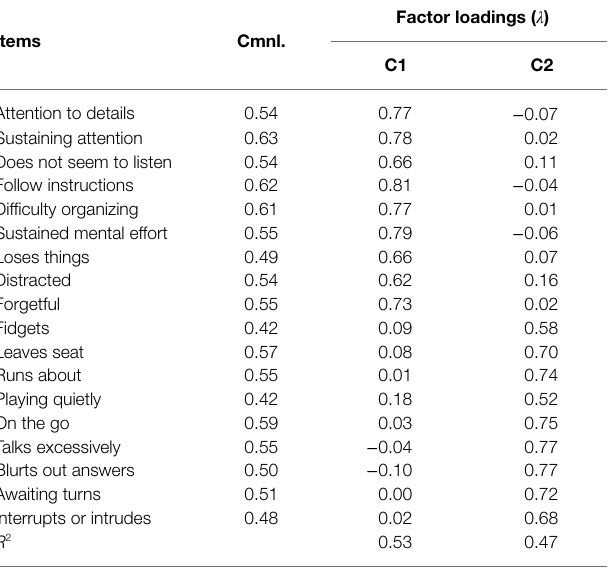
TABLE 3 | EFA-results for the symptom items of the ADHD Rating Scale—5.